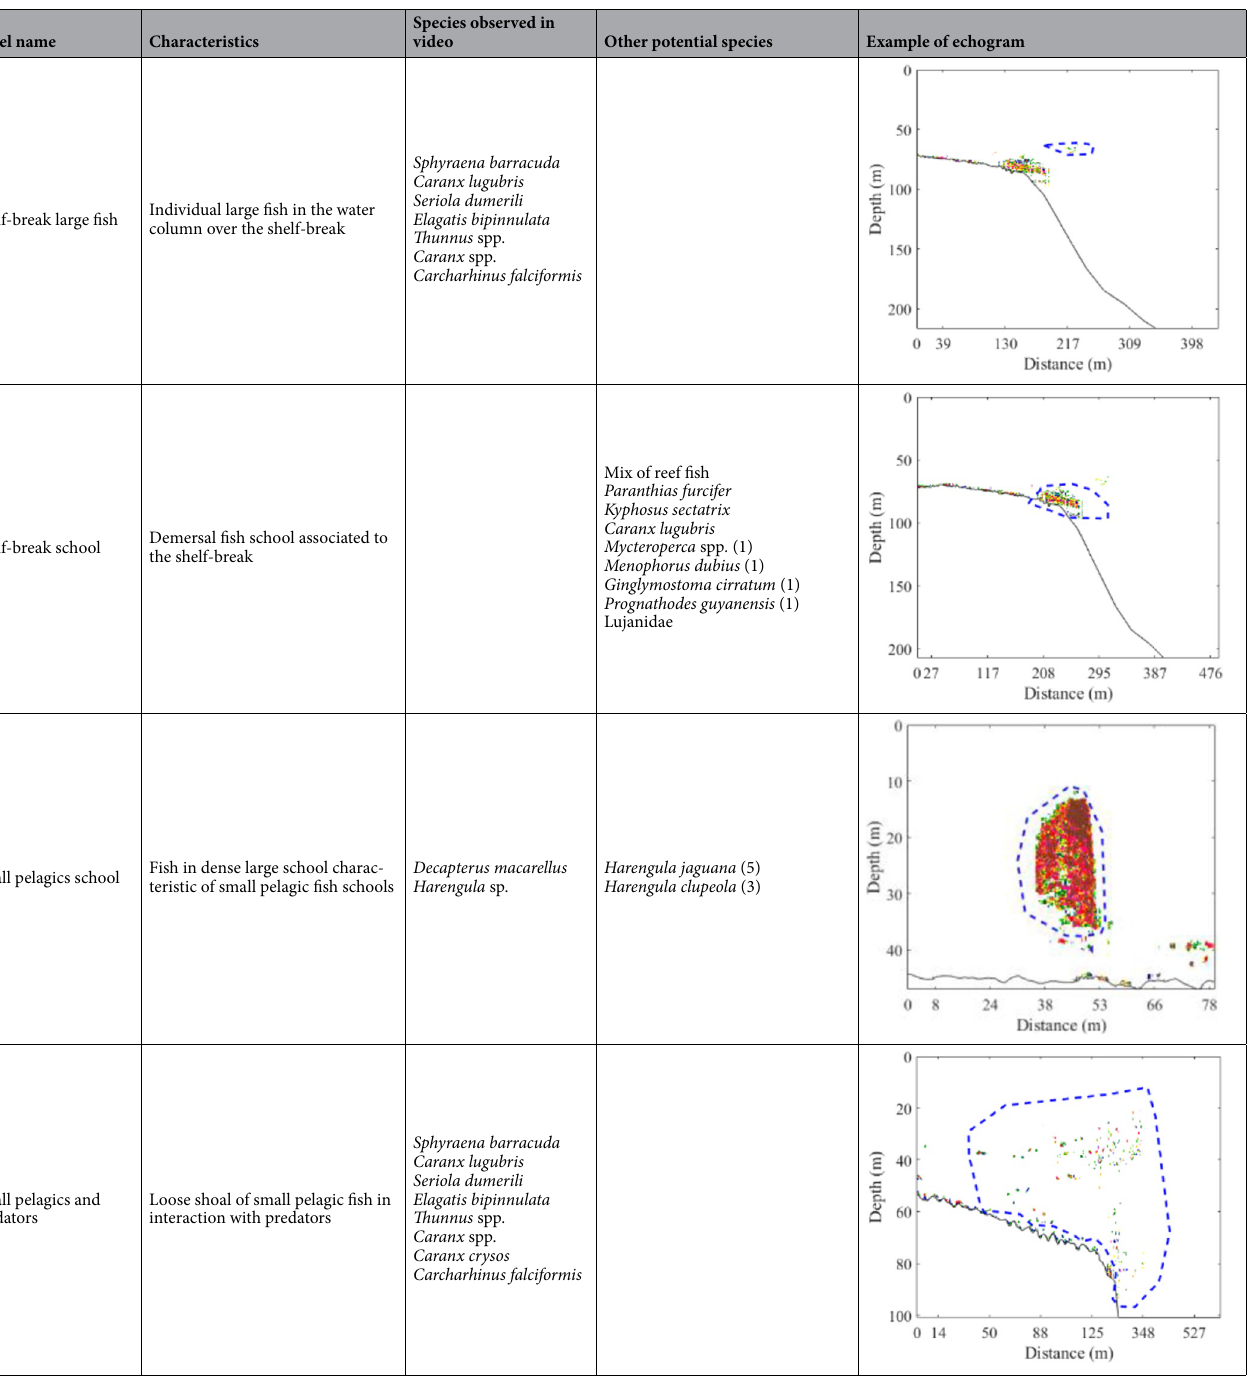
Table 2. Description of the fish assemblages and two fish species defined from echotypes (surrounded by a blue dashed line). (1) Barros (2020) 93 . (2) Sazima et al. (2005) 94 . (3) Soto (2001) 95 . (4) Krajewski and Floeter (2011) 96 . (5) Sazima et al. (2006) 97